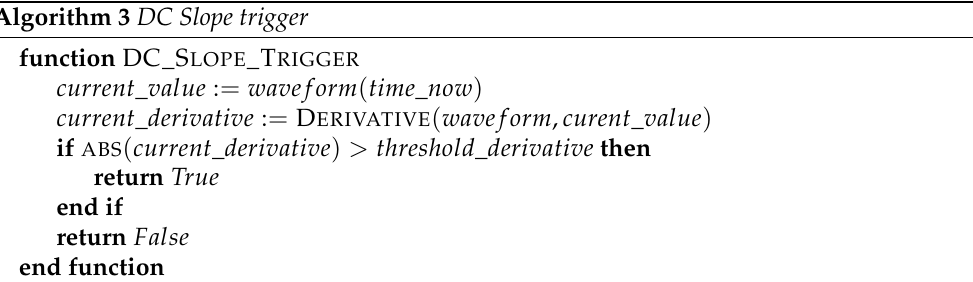
Algorithm 3 DC Slope